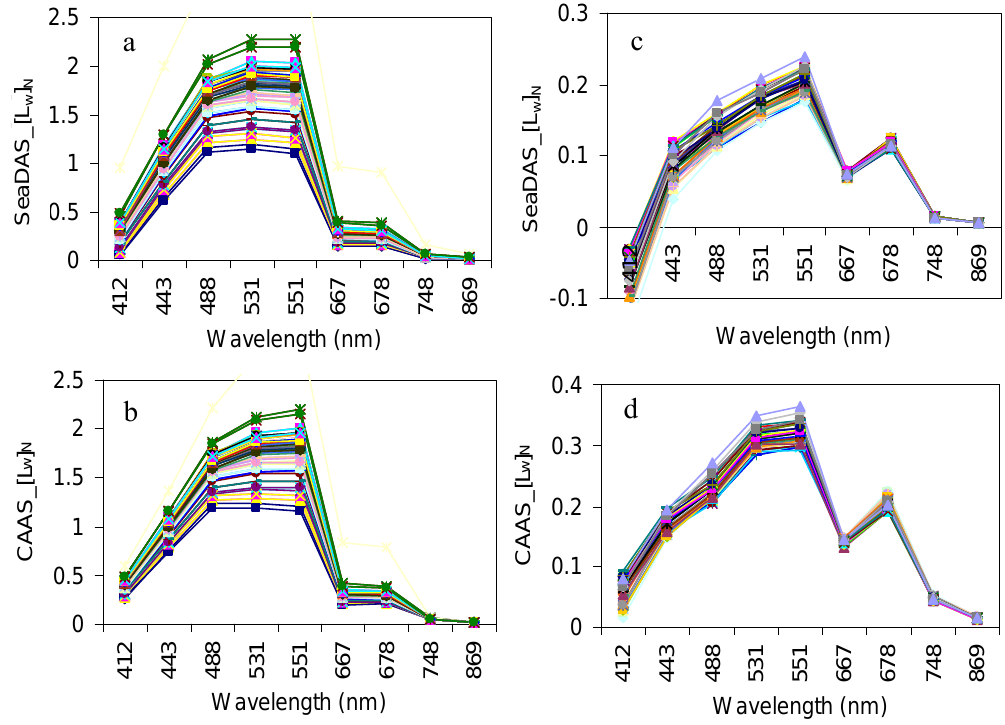
Fig. 5. Comparison of the water-leaving radiance spectra [ L w ] N for turbid waters (a) – (b) and algal bloom waters (c) – (d) obtained from MODIS-Aqua image (4 December 2010) using the SeaDAS and CAAS algorithms. These spectra are from bloom and turbid waters in the East China Sea (see arrow marks in Fig. 3c).